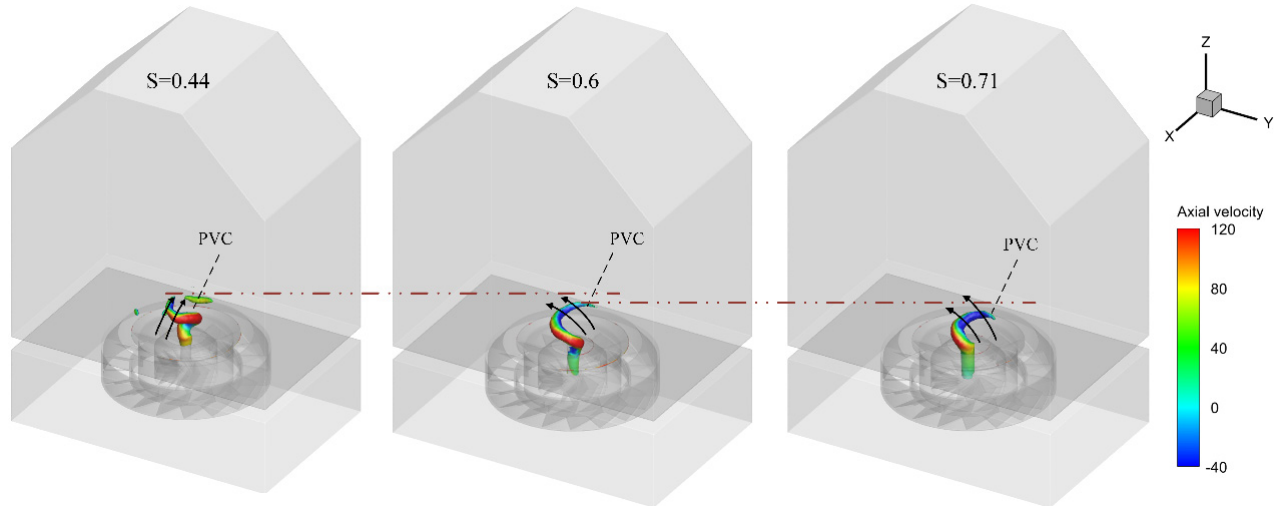
Figure 8. PVC in the combustor with different pilot − stage swirl numbers (colored by axial velocity).